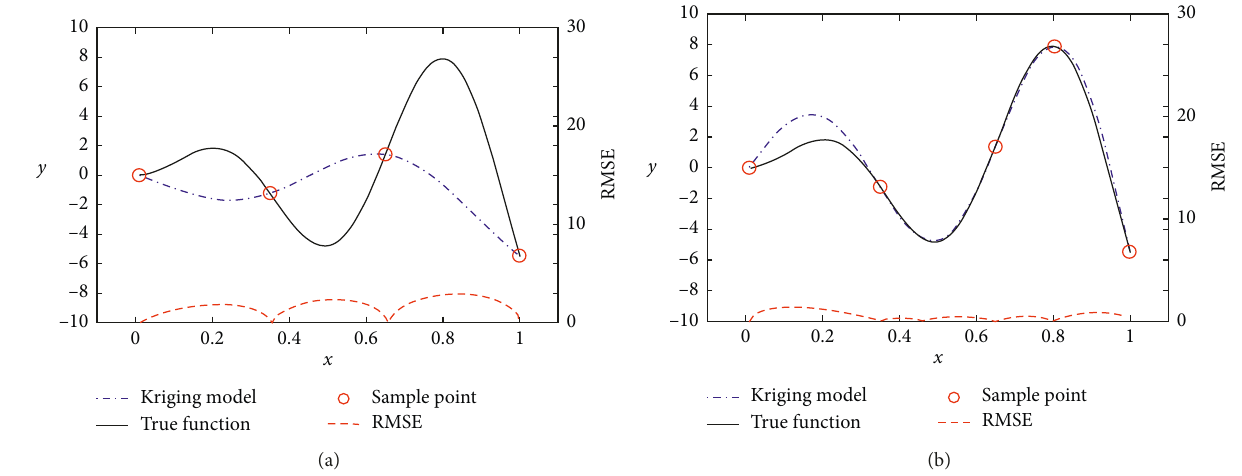
Figure 1: RMSE distribution of Schwefel function. (a) Before adding point. (b) After adding